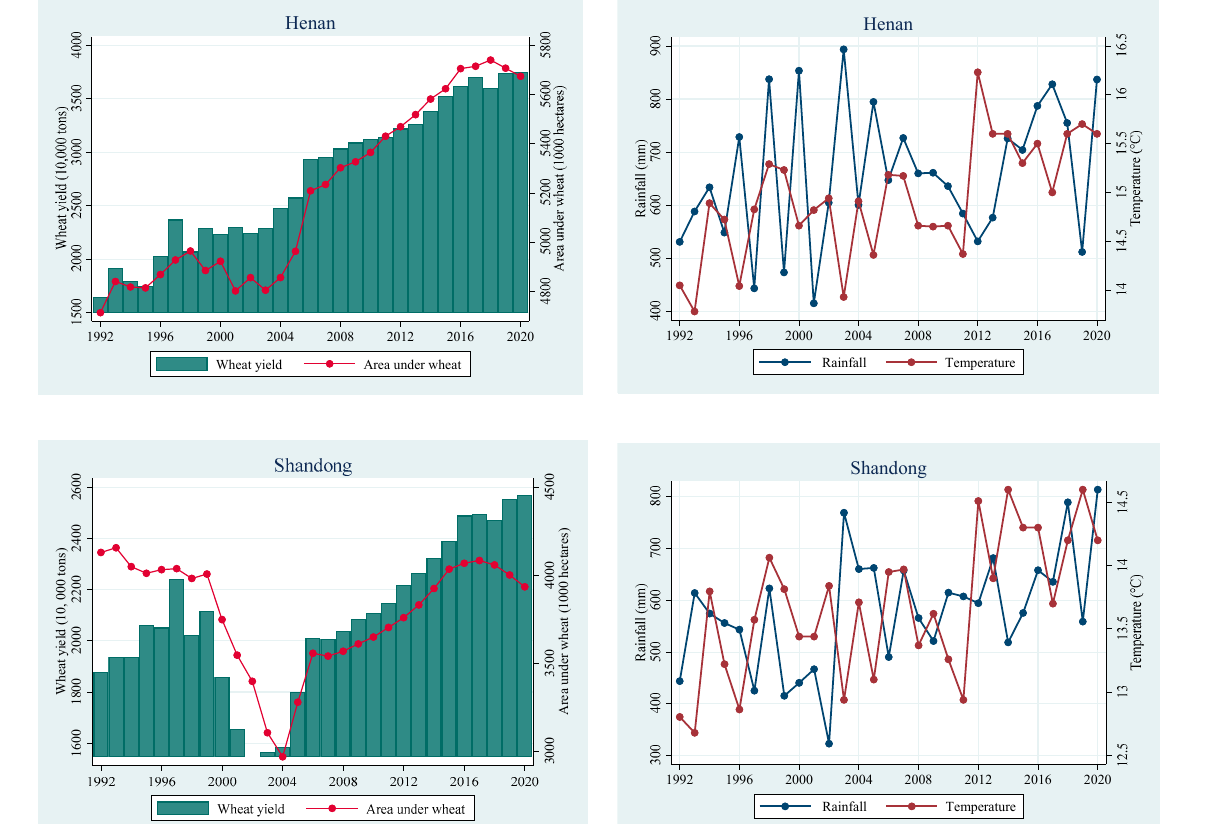
Figure 4. Trend of wheat production, temperature, and rainfall in Hebei, Henan, and Shandong Provinces of China.